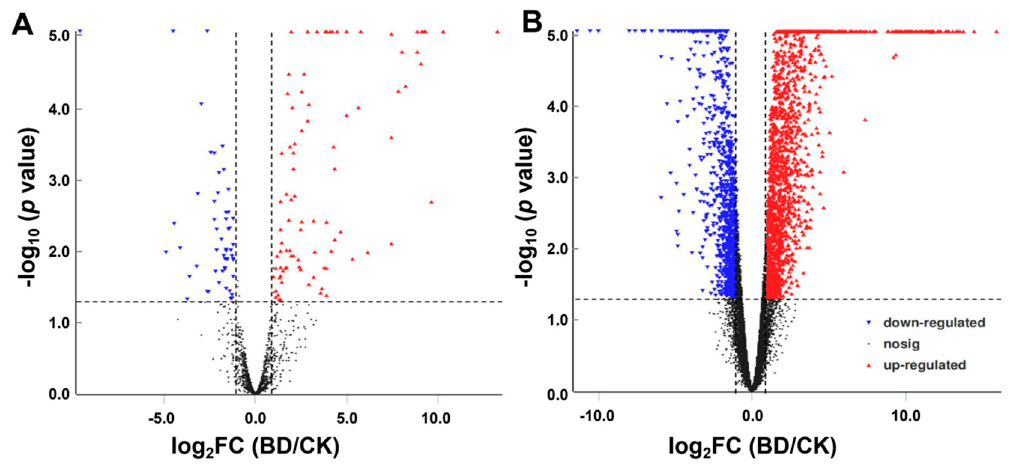
Figure 6. lncRNAs and mRNAs profile comparisons between BD and CK. Volcano plots were used to distinguish the di ff erentially expressed lncRNAs ( A ) and mRNAs ( B ). The vertical lines correspond to 4-fold up-regulation or down-regulation, and the horizontal line represent p = 0.05. The red triangle and green triangle highlight the up-regulated and down-regulated lncRNAs or mRNAs, respectively. BD: Boron deficiency; CK: Control.